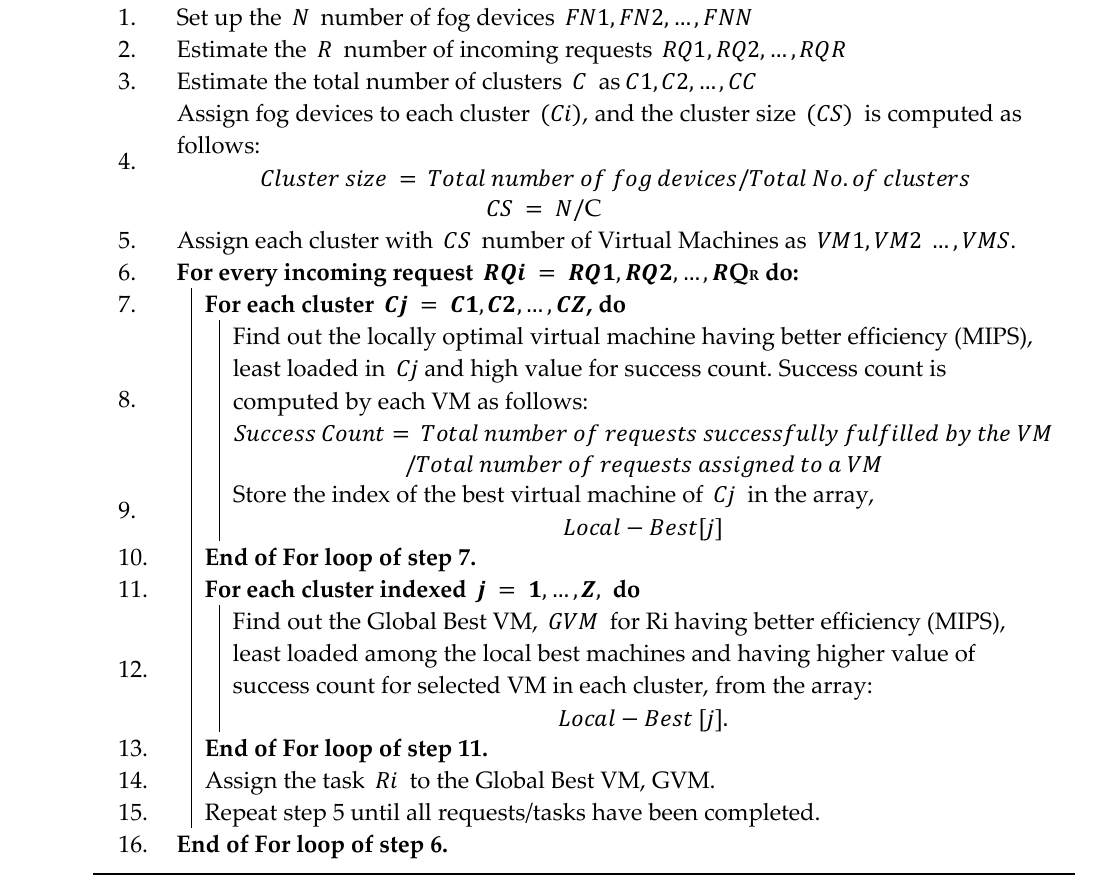
Algorithm 1: Cluster-Based Algorithm for Load Balancing in Fog